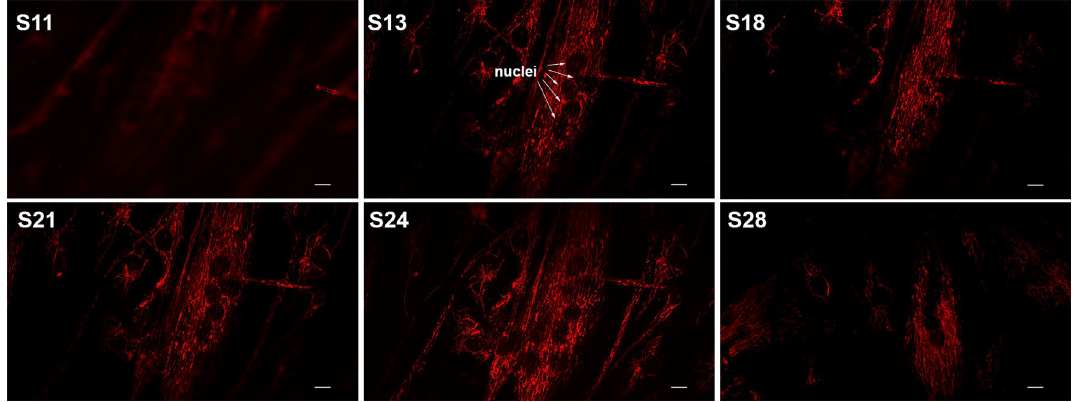
Figure 2. Representative confocal images of mitochondrial localization in differentiated myotubes of the Megaconial CMD patient. In the Z plane, 8-micron optical sections were taken from top to bottom and the optical section numbers are indicated on the figure. White arrows show the localization of the nuclei within the myotube. Red/Texas Red: TOM20/mitochondria, S: Section number. Scale bars: 10